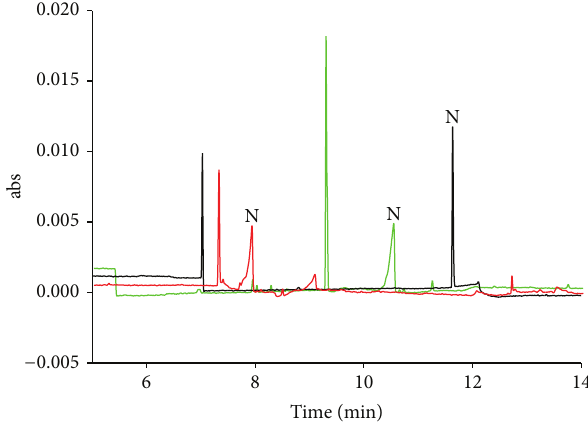
Figure 2: Electropherograms of runs 10 (blank line), 13 (red line), and 15 (green line) in CCD. CE conditions: separation buffer: 50 mM phosphate buffer (pH 3) containing methanol; sweeping buffer: 50 mM phosphate buffer (pH 3) containing 20% methanol and SDS; HCB: phosphate buffer (pH 3); applied voltage, − 20 kV. Sample injection: 15 kV, 15 min. Nicotine concentration: 617 nM. Other conditions are shown in Table